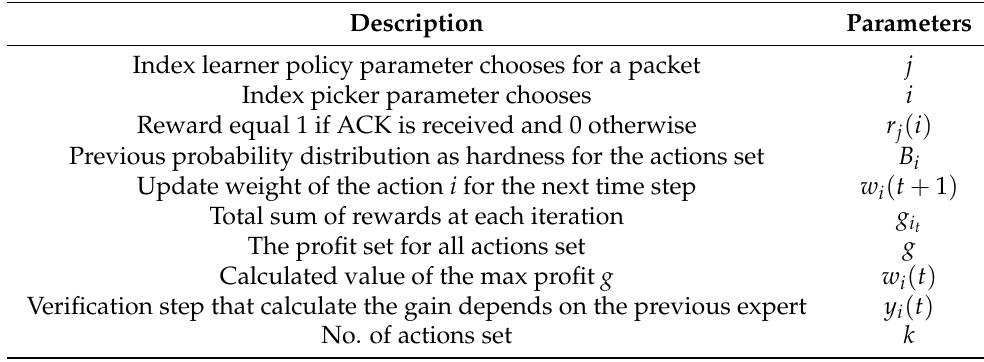
Figure 3. The proposed LoRa smart node simulation flow chart. Table 1. Approach Parameter